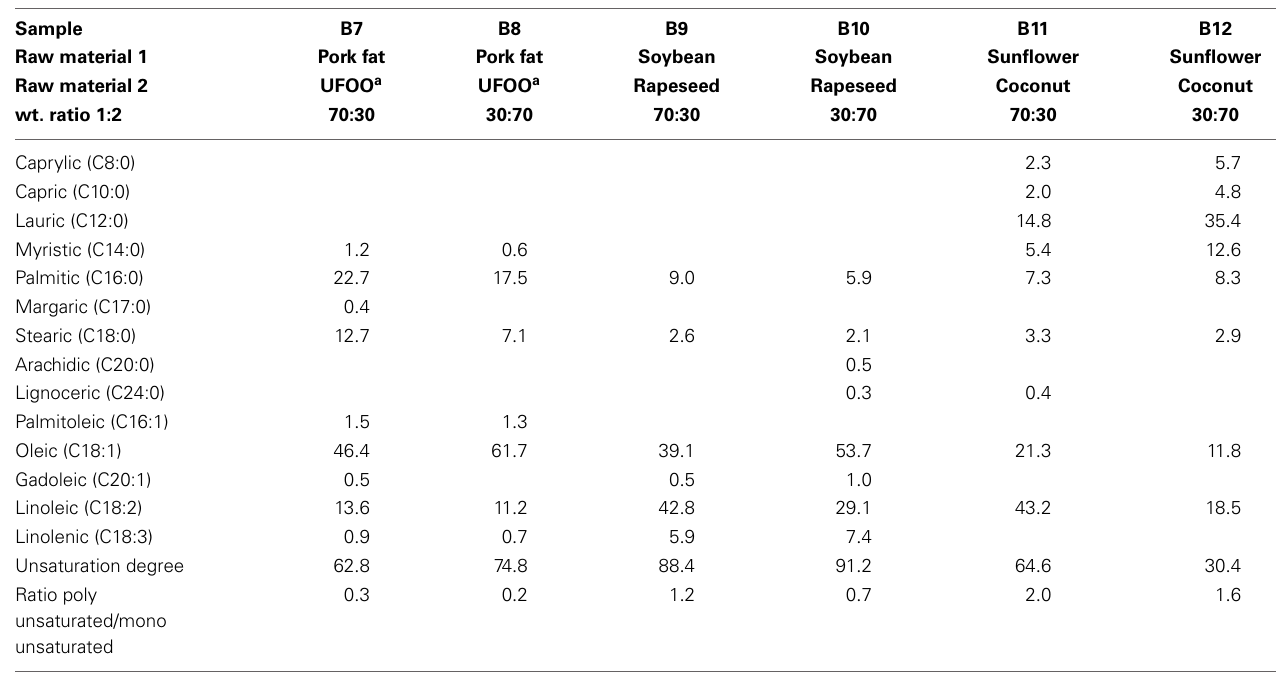
Ratio poly unsaturated/mono unsaturated a Used frying olive oil.